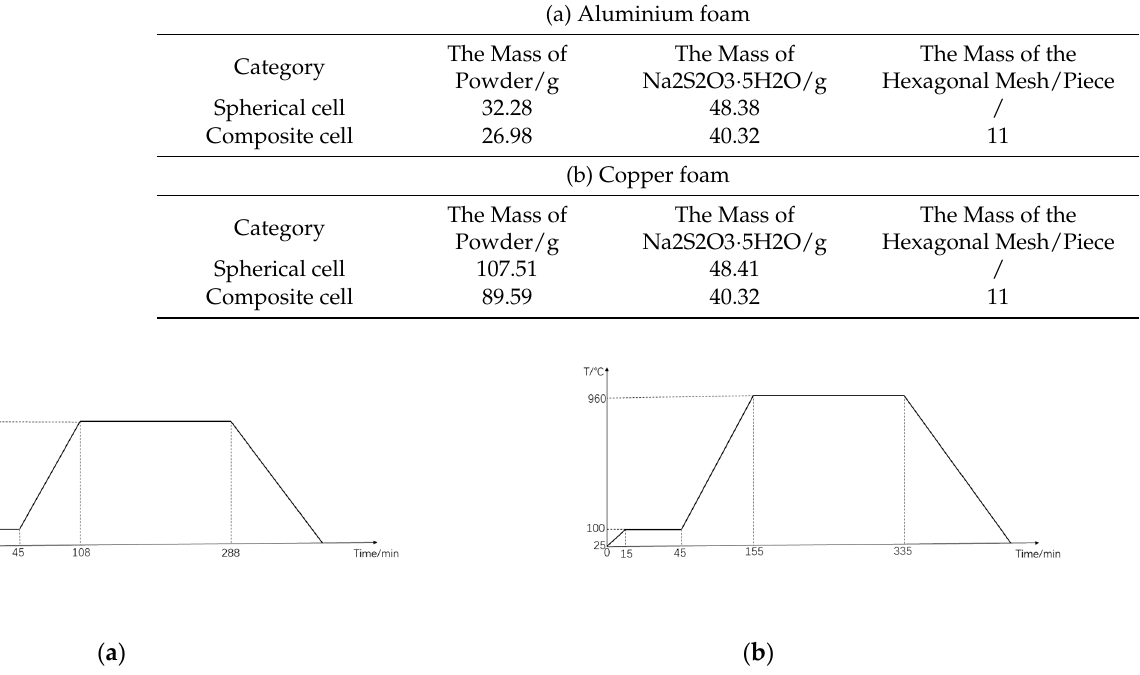
Figure 3. The temperature rise curve, ( a ) the aluminium foam, and ( b ) the copper foam (Ar 2 was introduced in the sintering process of copper foam).